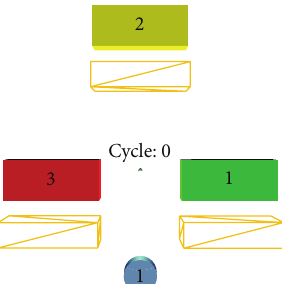
Figure 5: Snapshot of the 3D environment including the robot and three color blocks rotating constantly clockwise and passing just in front of the color sensor of the robot.